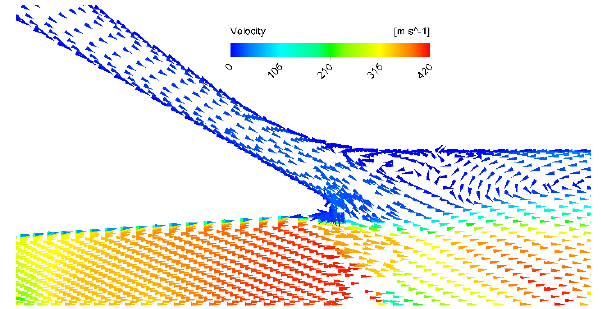
Fig. 14. Vectors of velocity magnitude for relative back- pressure p 4 /p 02 = 1.62, (157 kPa abs) in the vicinity of the motive nozzle